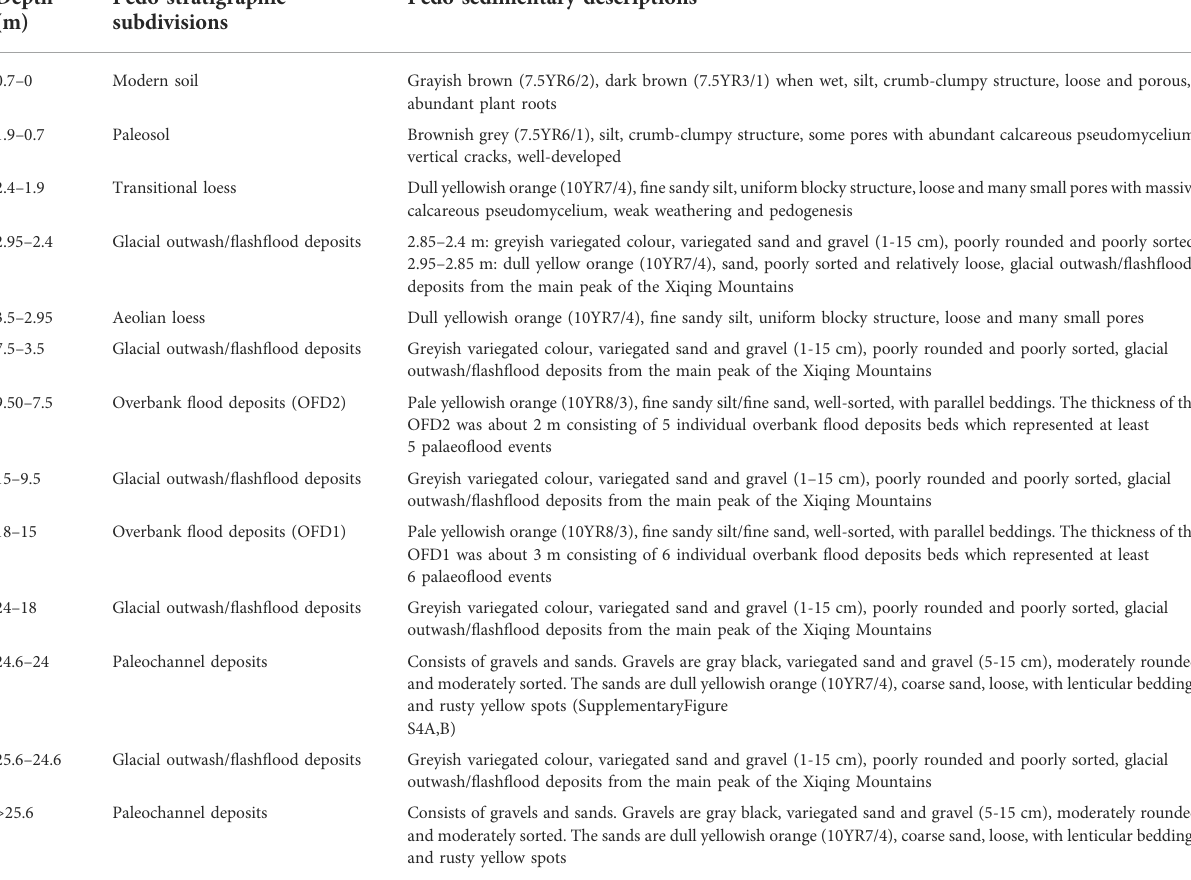
TABLE 2 Pedo-stratigraphic subdivisions and descriptions of the ZHK pro fi le in the Yellow River source area on the NE Tibetan Plateau.